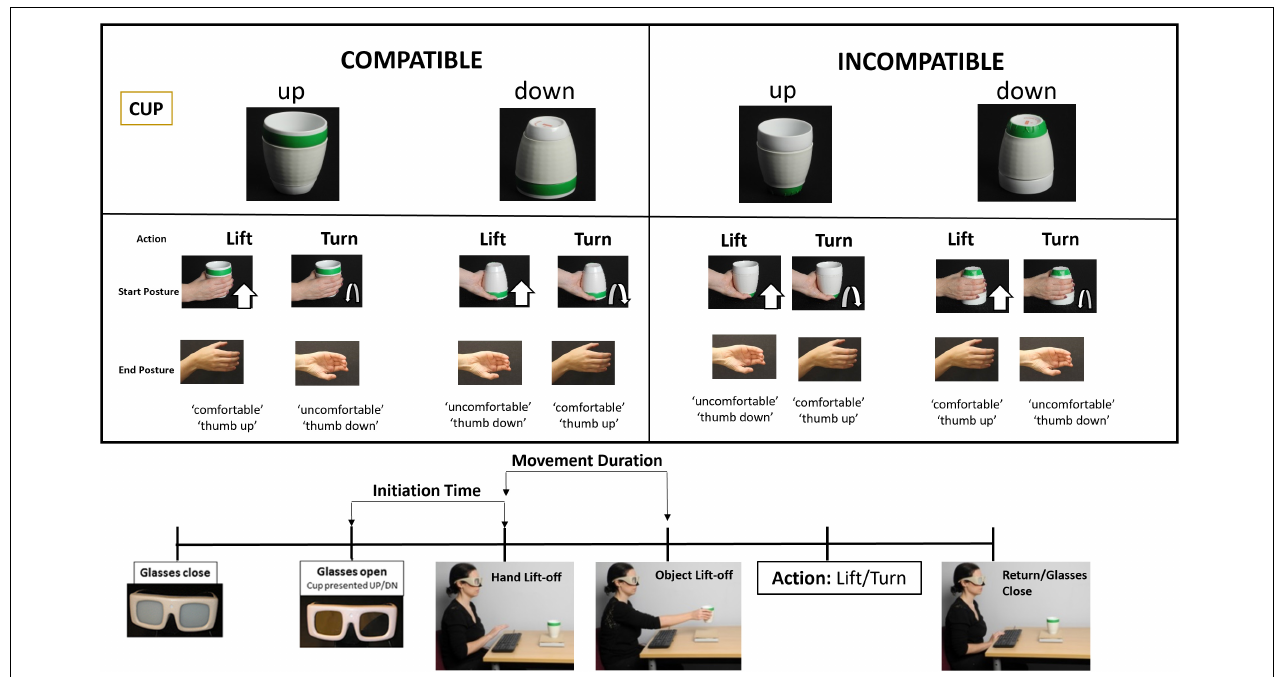
FIGURE 1 | Conditions and task. The top panel shows the eight task conditions. Participants were asked to “lift” or “turn” a cup by grasping it from the green line marking. In half of the trials, this marking was compatible with the familiar way of grasping a cup (with the thumb pointing toward its open end), and in the other half, it was in the opposite (closed end) of the cup. The end-state comfort depended on the initial hand position and action performed. It was either comfortable (meaning that the thumb was oriented up at the end of the action) or uncomfortable (thumb oriented down). The bottom panel shows the time course of a trial. Participants started with their hand resting on a keyboard. The initiation times represented the time between opening of the glasses, which coincided with a verbal cue indicating the action (to lift or turn the cup), and the time of lift-off of the hand from its resting position on the keyboard. The movement durations represented the time between lift-off of the hand and the time to lift the object from its pad, to carry out the action. This represented the time reaching to grasp the cup. Please note that the individuals present in the figure gave informed consent to have this image